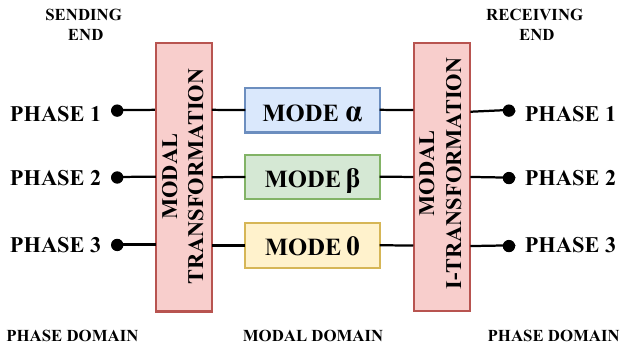
Figure 4. Modal- and phase-domain representations for modeling a three-phase